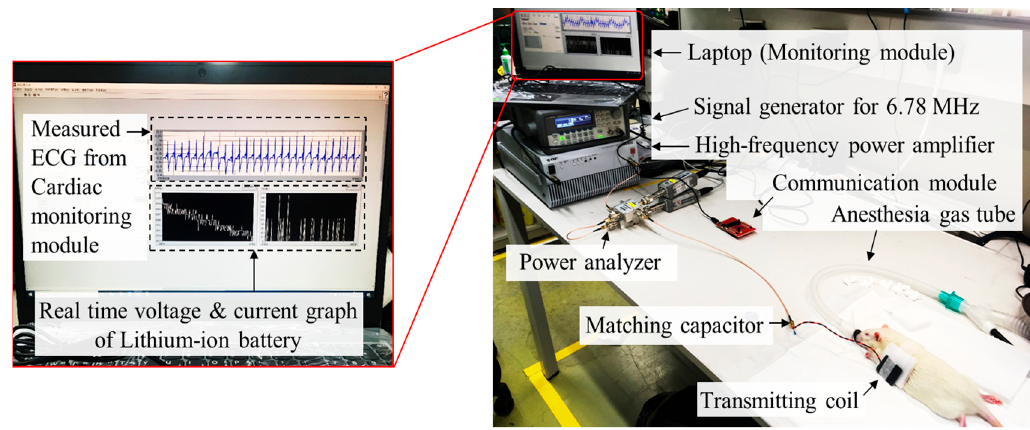
Figure 16. Photographs of animal experiment and ECG, voltage, current of battery graph displayed on monitoring module (laptop).